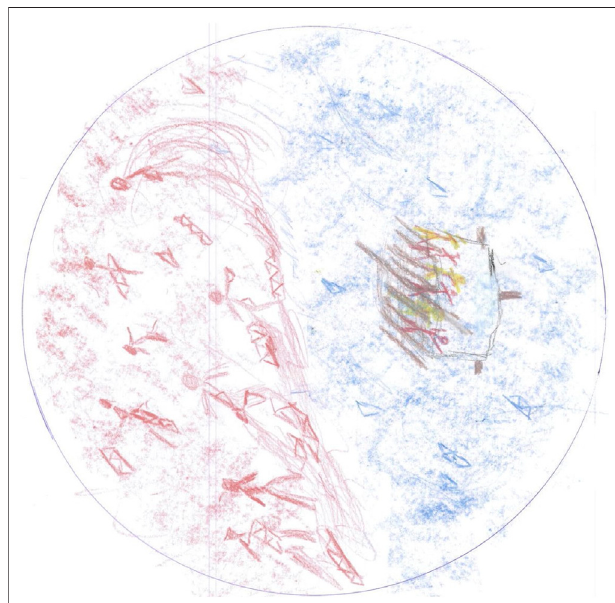
FIGURE9| Withhighspiritsandachild-likeexcitement,Istartedtothink about how the Norwegian adventurer Thor Heyerdahl crossed the Paci fi c Ocean on a raft to prove that life was big and beautiful. I see long realistic passagesthatmademelaughandfeelagreatinnerjoy.Report19,male, CME, MEQ total